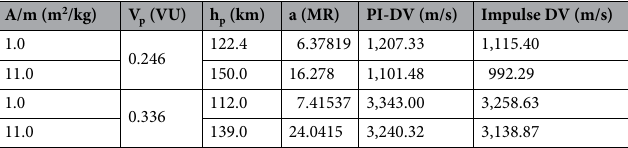
Table 2. DV comparison between a pure impulsive maneuver and